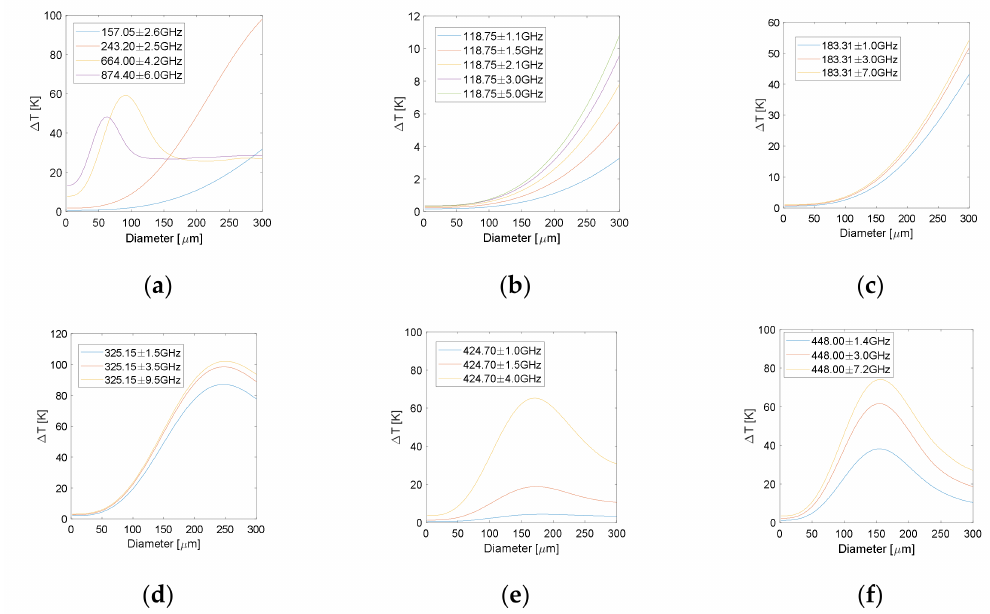
Figure 3. Brightness temperature di ff erence caused by di ff erent e ff ective particle sizes. ( a ) Window. ( b ) 118.75 GHz (O2). ( c ) 183.31 GHz (H2O). ( d ) 325.15 GHz (H2O). ( e ) 424.70 GHz (O2). ( f ) 448.00 GHz